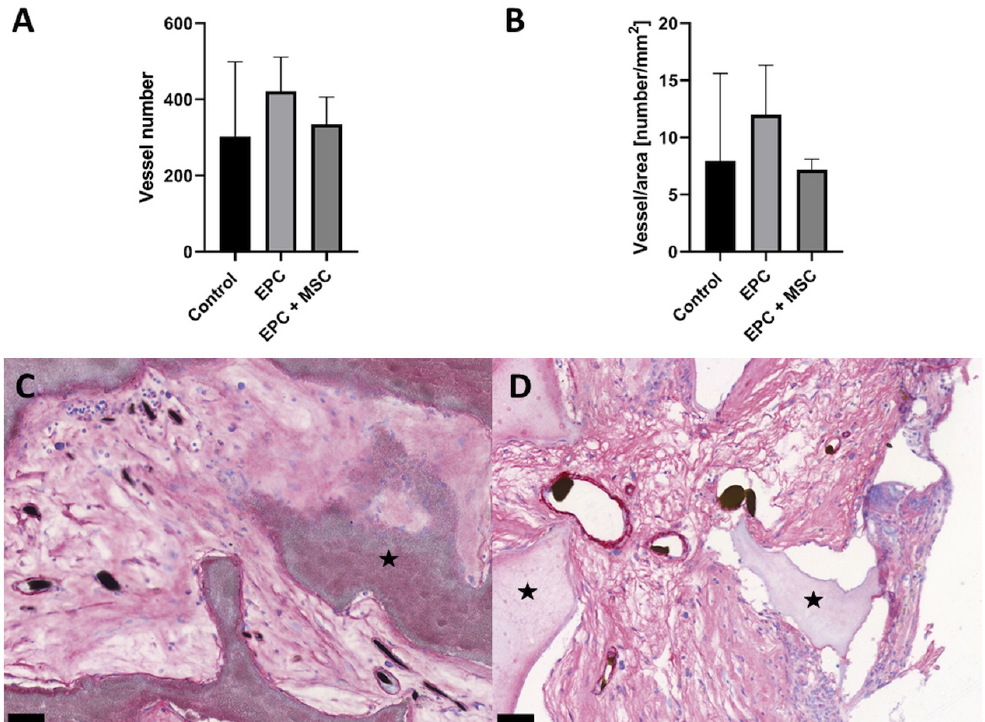
Figure 6. Quantification and detail view of vascularization. No statistically significant differences regarding the vessel number and vessel density were detected in the three groups ( A , B ). The newly formed vessels are filled with either Microfil ® or India ink solution and display a red-colored media layer in the α –SMA staining ( C , D ). Because no differences between the three groups exist, exemplary histological slices from group A and C are demonstrated ( C , D ). The black stars indicate the HA/ß–TCP granula. Scale bar = 50 µm.